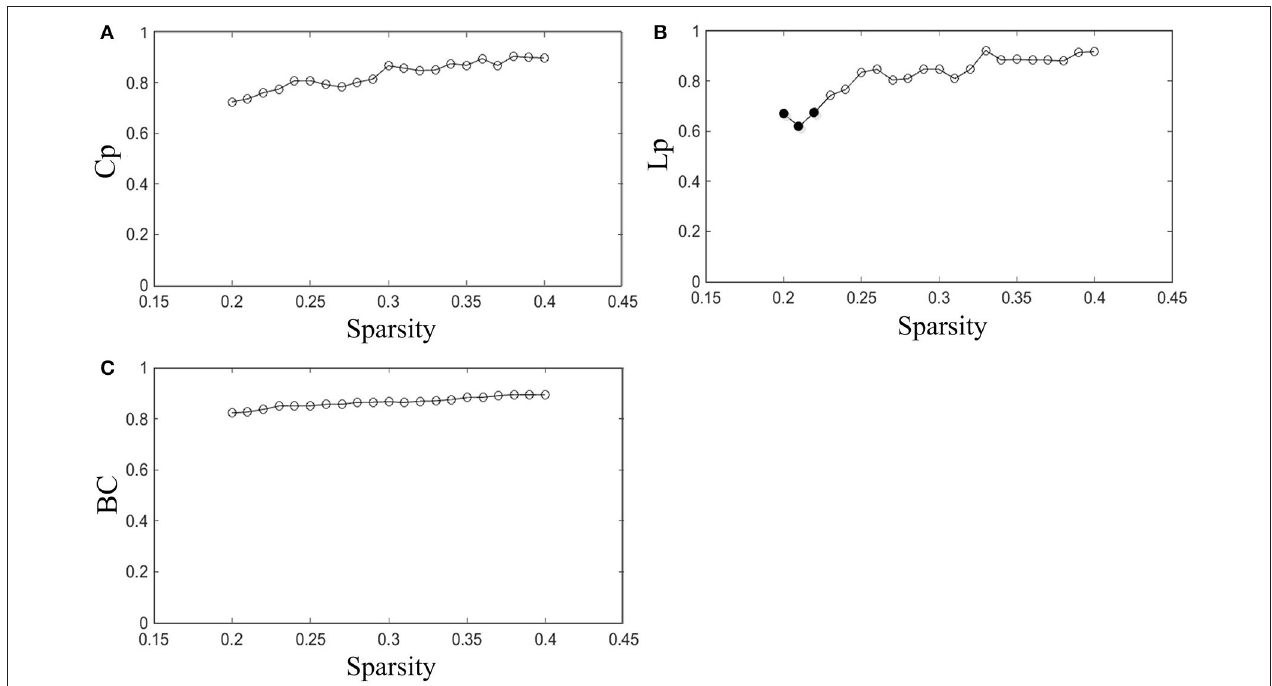
FIGURE 3 | Reproducibility of the method. (A–C) Represent the ICC of Cp, Lp , and BC as a function of sparsity, respectively. The hollow dots indicate the significant results.